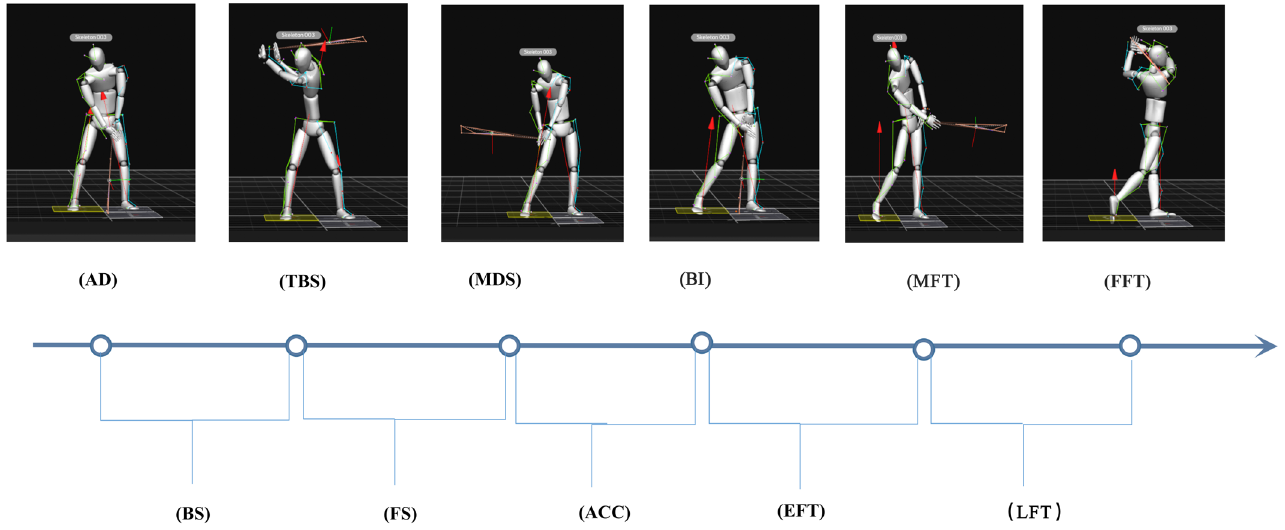
Figure 3. Phases of a Golf Swing. The golf swing was divided into five phases; backswing (BS), forward swing (FS), acceleration (ACC), early follow ‐ through (EFT), and late follow ‐ through